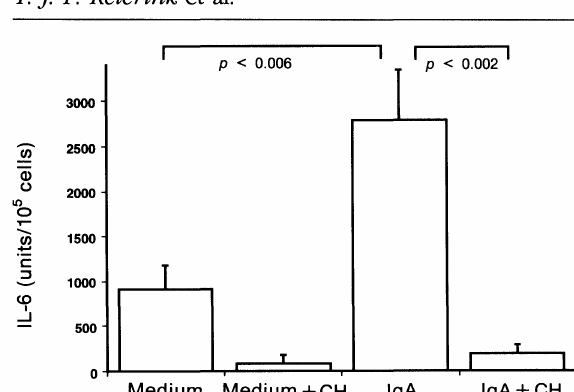
FIG. 4. Effect of cycloheximide on the production of IL-6 by MC /n v/tro. MC were incubated in triplicate with medium alone or medium supplemented with human dimeric IgA (10 g/ml), with or without cycloheximide (1 Ag/ml). Aer 72 h, the supernatants were hawested and assessed for IL-6. Results are expressed as the mean S.E.M.